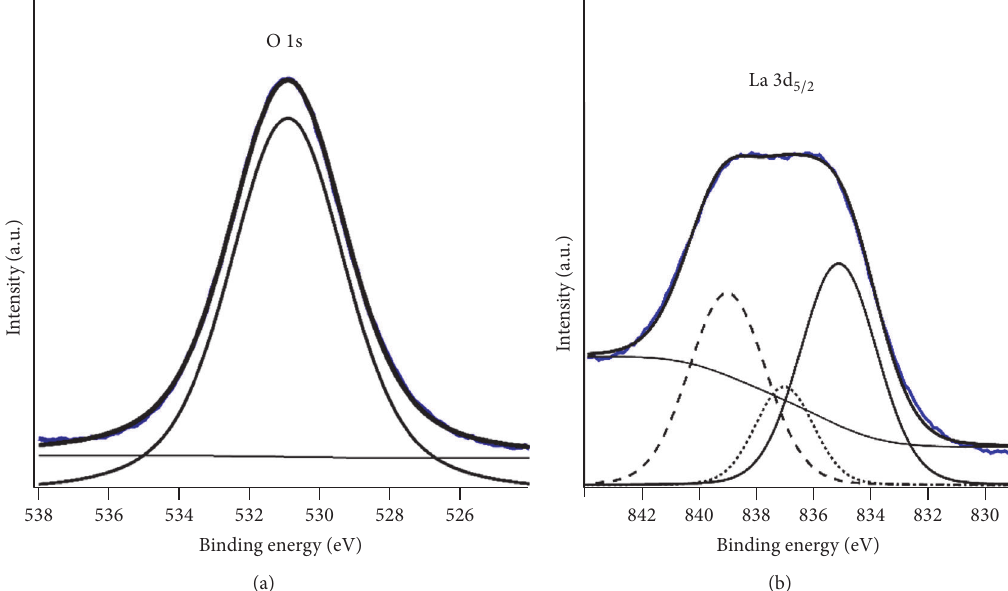
Figure 14: XPS high resolution single peak analysis for (a) O1s peak and (b) La3d 5/2 peak performed on the sample sealed in an aqueous solution with 12 g/L of La(NO 3 ) 3 at 50 ∘ C for 30 min.